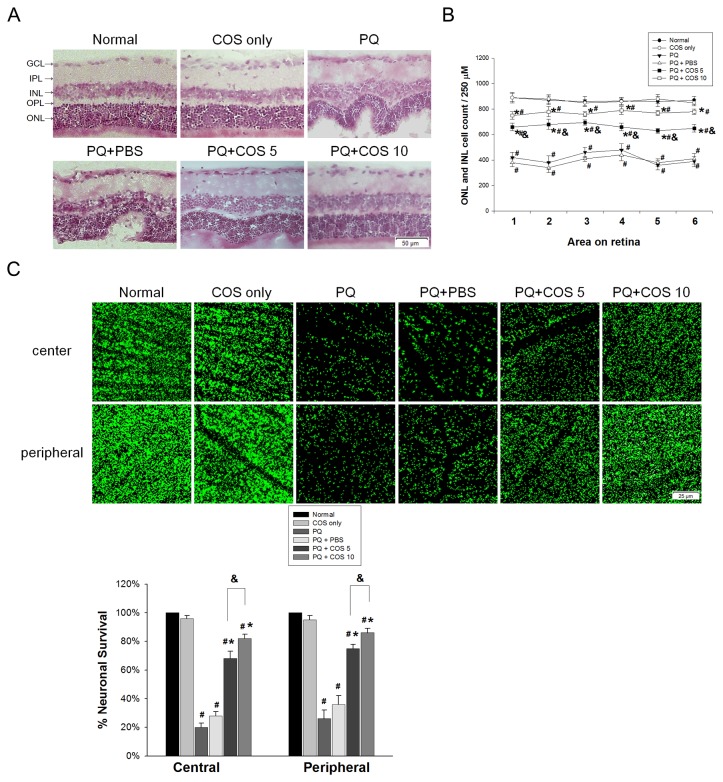
Effects of COS on retinal morphology, retinal cells and ganglion cell layer count.(A). PQ-injected rats showed diffuse thinning of inner and outer nuclear layer (INL, ONL) and folds in ONL, while low-dose or high-dose COS treatment showed better preservation of the INL and ONL at day 14. (B). low-dose and high-dose COS-treated group significantly preserved more cells in INL and ONL than PBS-treated and untreated group. (N=5 in each group). (C). Representative confocal images of Neu N-labeled neurons (green) in the regions of center and peripheral flat-mounted retinas of four groups. Neu N is the neuron marker for the quantification of surviving neurons in the ganglion cell layer (GCL). The percentage of surviving neurons in the GCL was significantly higher in COS-treated group than PBS-treated and untreated groups both in the center and peripheral regions of retinas at day 14. (N=3 in each group). (*P < 0.05 compared with PQ only or PBS-treated group; # P < 0.05 compared with normal; & P< 0.05 by ANOVA test with post hoc Bonferroni test).